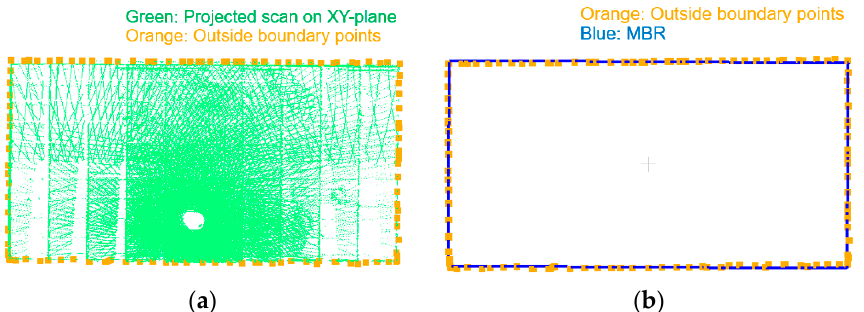
Figure 19. Example boundary tracing of a facility. ( a ) Boundary points extracted from projected point cloud and ( b ) defined MBR for the boundary points.